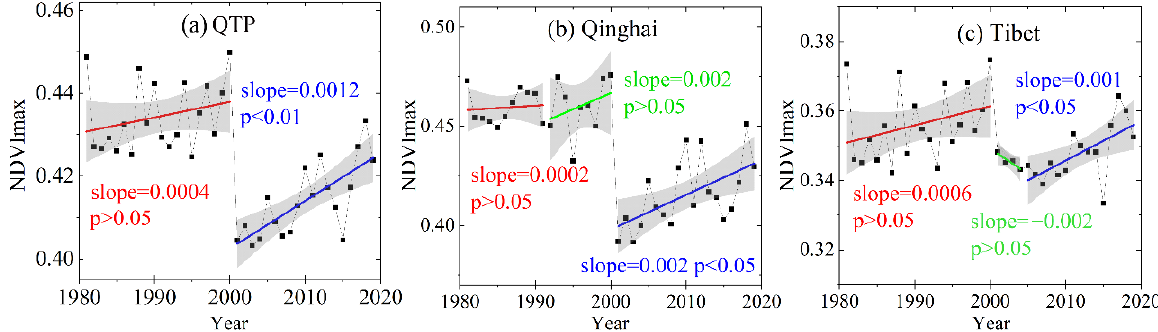
Remote Sens. 2021 , 13 , x FOR PEER REVIEW Figure 9. Interannual variations of NDVI max in the QTP ( a ), Qinghai ( b ), and Tibet ( c ).